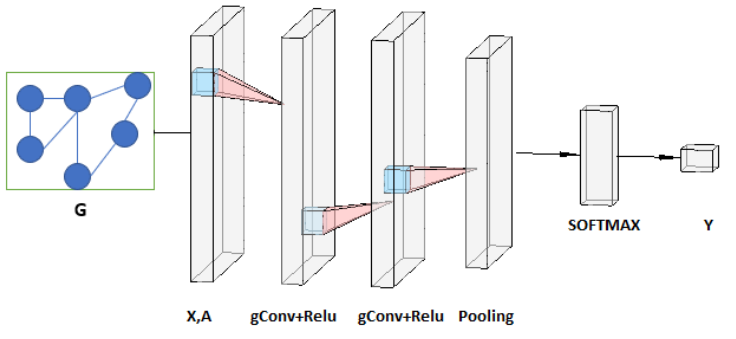
Figure A2. An example of a convolutional graph neural